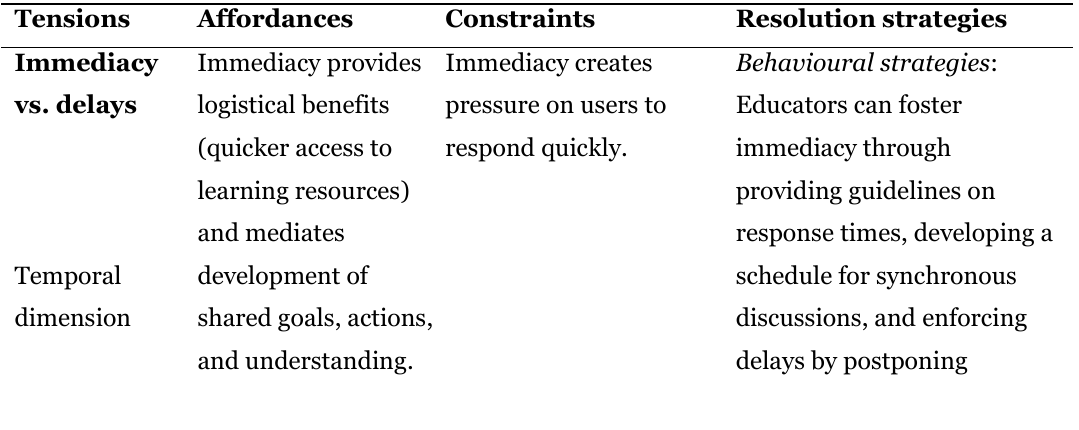
Overview of Tensions, Affordances, Constraints, and Resolution Strategies